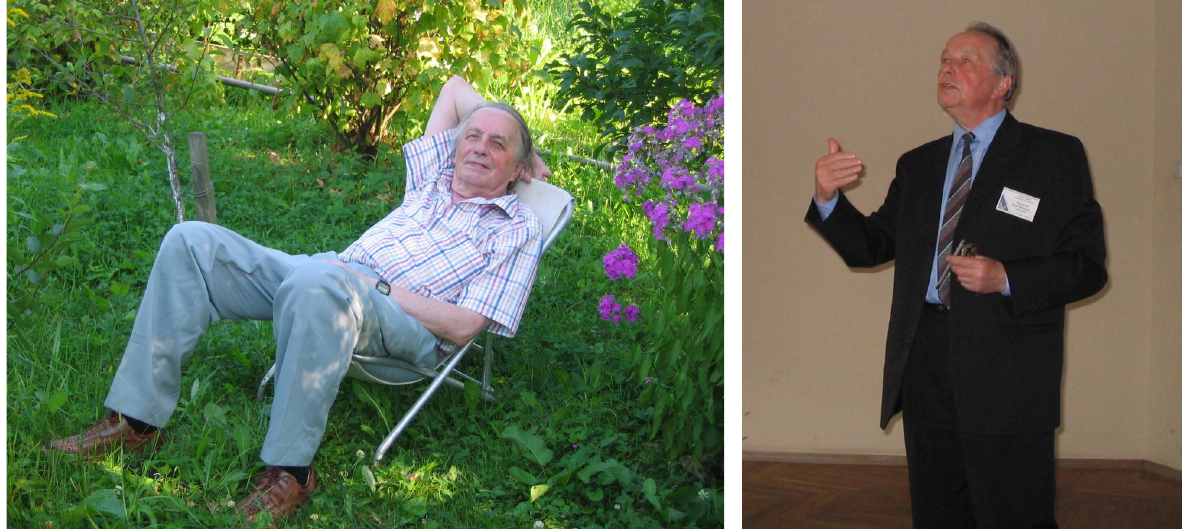
Figure 1. Yury N. Gnedin. ( Left ): A rare moment of leisure on his birthday, 13 August 2007, near his summer cottage. ( Right ): At a conference (June 2004). Courtesy to Oleg